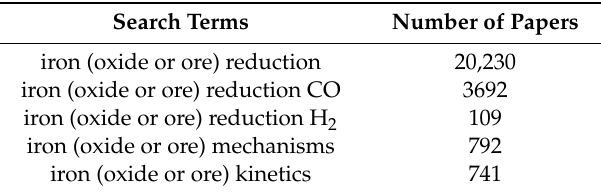
Table 3. Publications on the reduction of iron oxides from 1900 to 2020.